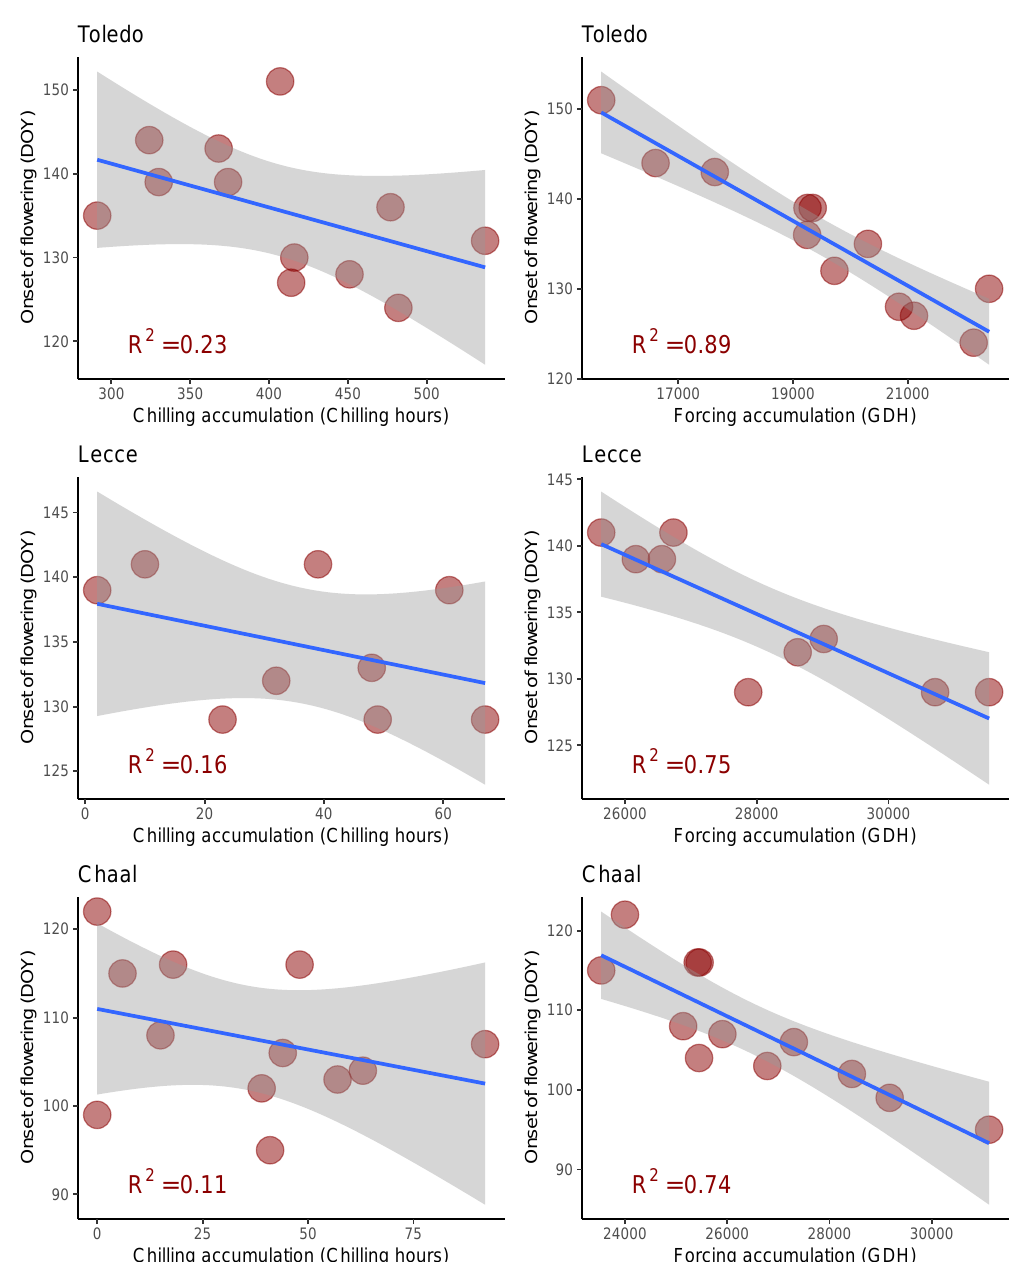
Figure 6. Regression analysis between the chilling and heat accumulation units with respect to the date of